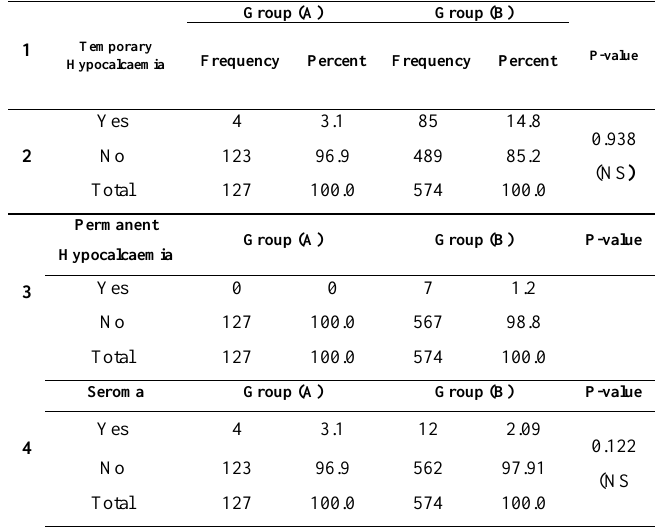
Table 4 : Table 4. Distribution of post-operative complications (hypocalcaemia and seroma) of the study